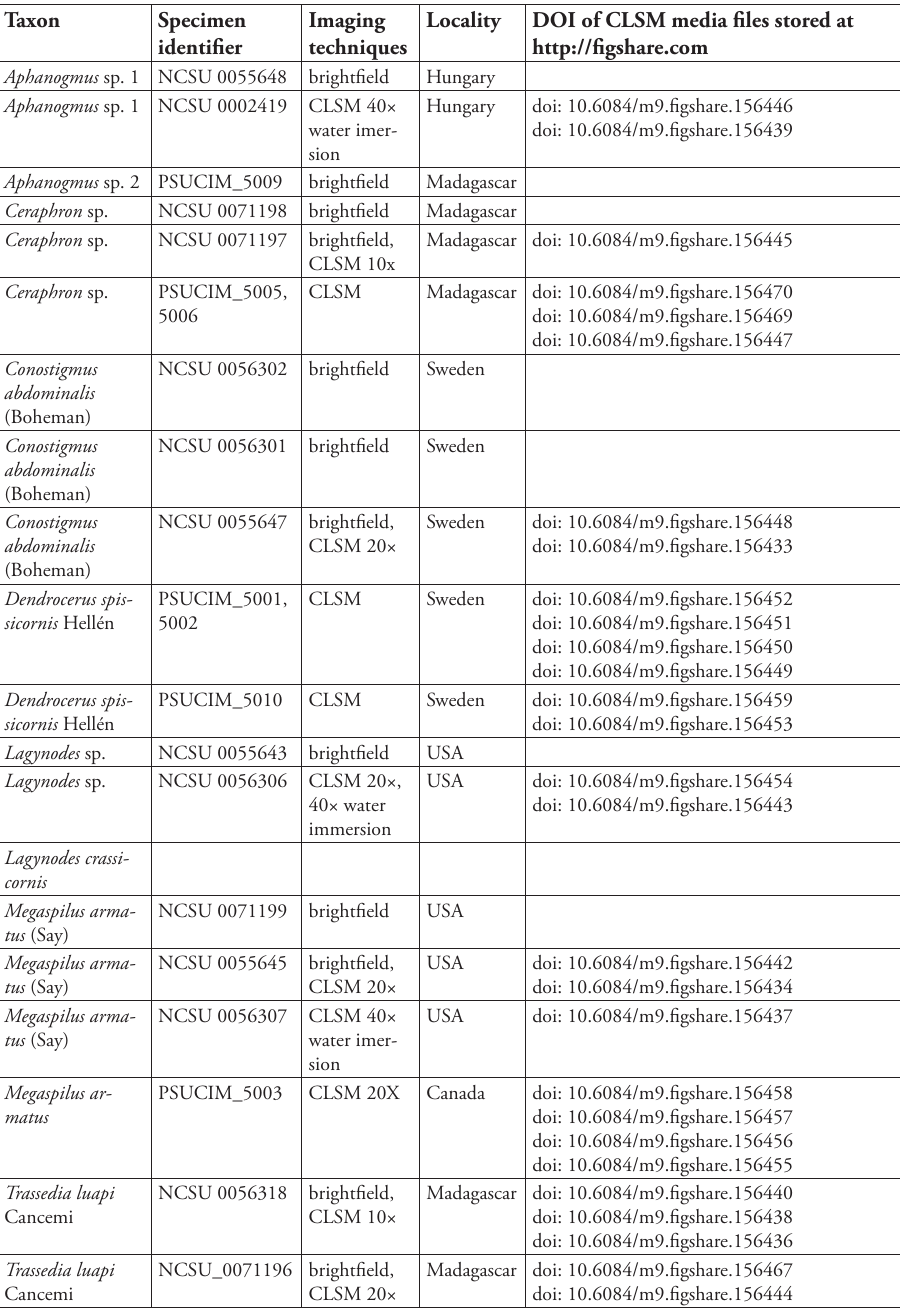
table 1. Specimens observed for morphological description including specimen identifiers, preparation techniques, imaging method and collecting locality (verbatim collecting data are stored at